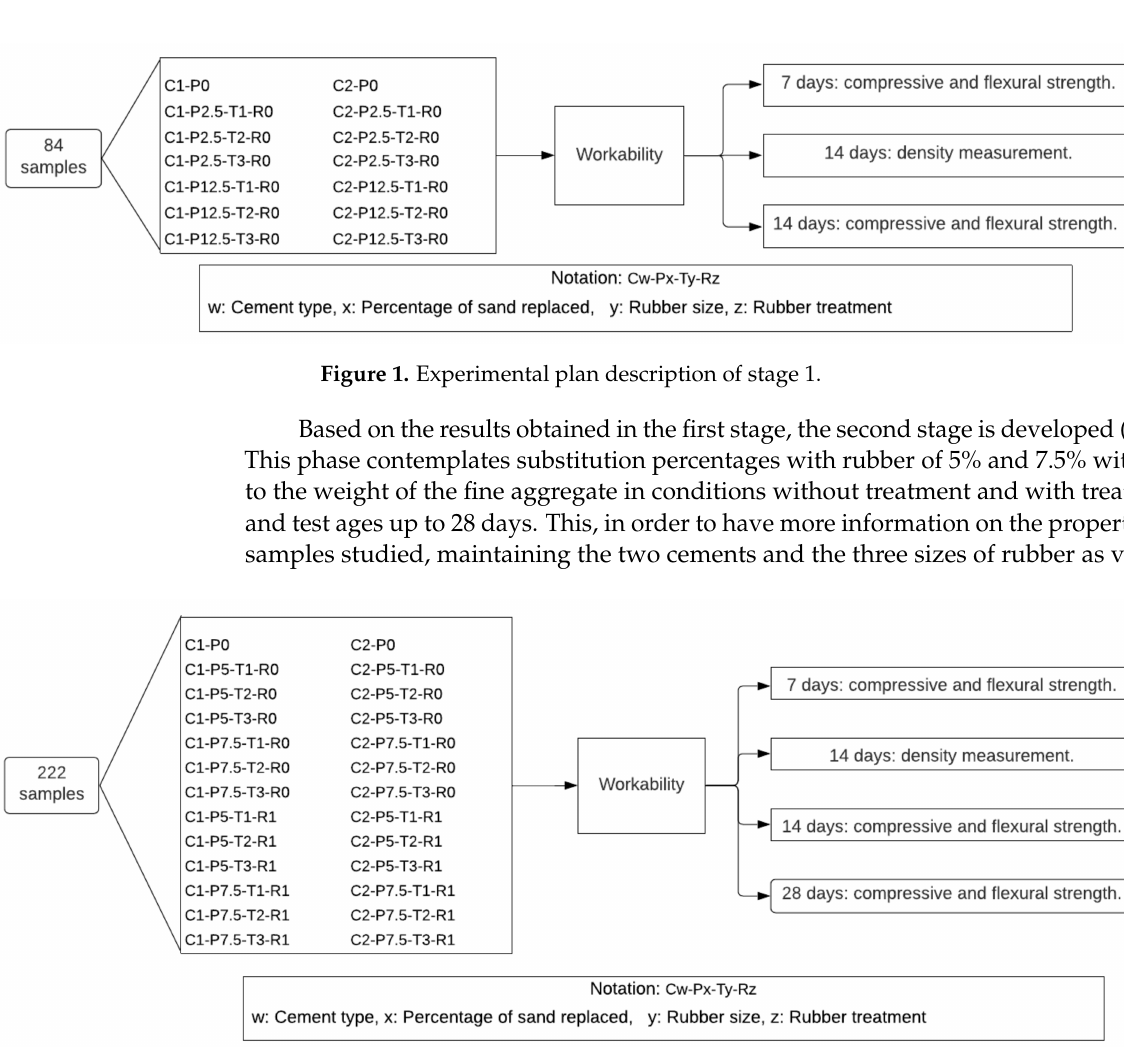
Figure 2. Experimental plan description of stage 2.